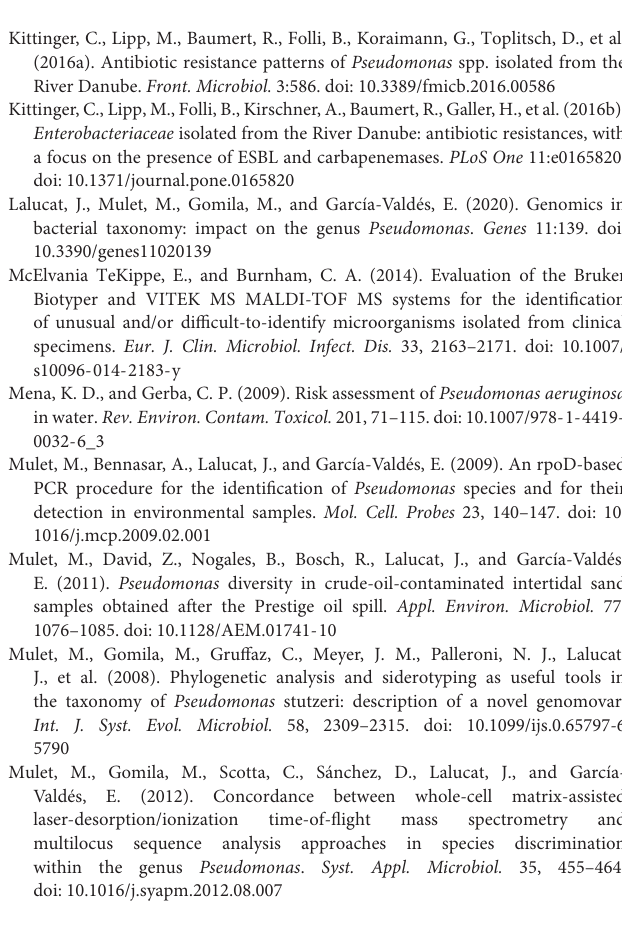
FIGURE S1 | MALDI-TOF MS dendrogram of the 611 Pseudomonas strains studied, their origin and assignation to MALDI-TOF groupings and phylospecies. FIGURE S2 | Phylogenetic relationships of the selected strains based on the partial rpoD gene sequence analysis. Distance matrices were calculated by the Jukes-Cantor method. Dendrograms were generated by the neighbor-joining method. Cellvibrio japonicum UEDA 107 T was used as the outgroup. The bar indicates sequence divergence. Percentage bootstrap values of more than 50% (from 1000 replicates) are indicated at the nodes. Filled circles indicate that the corresponding nodes were also obtained in the trees generated with the maximum-likelihood and maximum parsimony methods. FIGURE S3 | Phylogenetic tree of the strains in the P. putida phylogenetic group based on the partial rpoD gene sequence analysis. Distance matrices were calculated by the Jukes-Cantor method. Dendrograms were generated by the neighbor-joining method. P. aeruginosa ATCC 10145 T was used as the outgroup. The bar indicates sequence divergence. Percentage bootstrap values of more than 50% (from 1000 replicates) are indicated at the nodes. Filled circles indicate that the corresponding nodes were also obtained in the trees generated with the maximum-likelihood and maximum parsimony methods. FIGURE S4 | Rarefaction curves. (A) Individual curves for the five sampling sites with the highest numbers of isolates; (B) All sampling sites and isolates. TABLE S1 | Location of the 14 sampling points along the Danube River and date of isolation. TABLE S2 | Partial rpoD gene sequences obtained in the present study and their corresponding accession